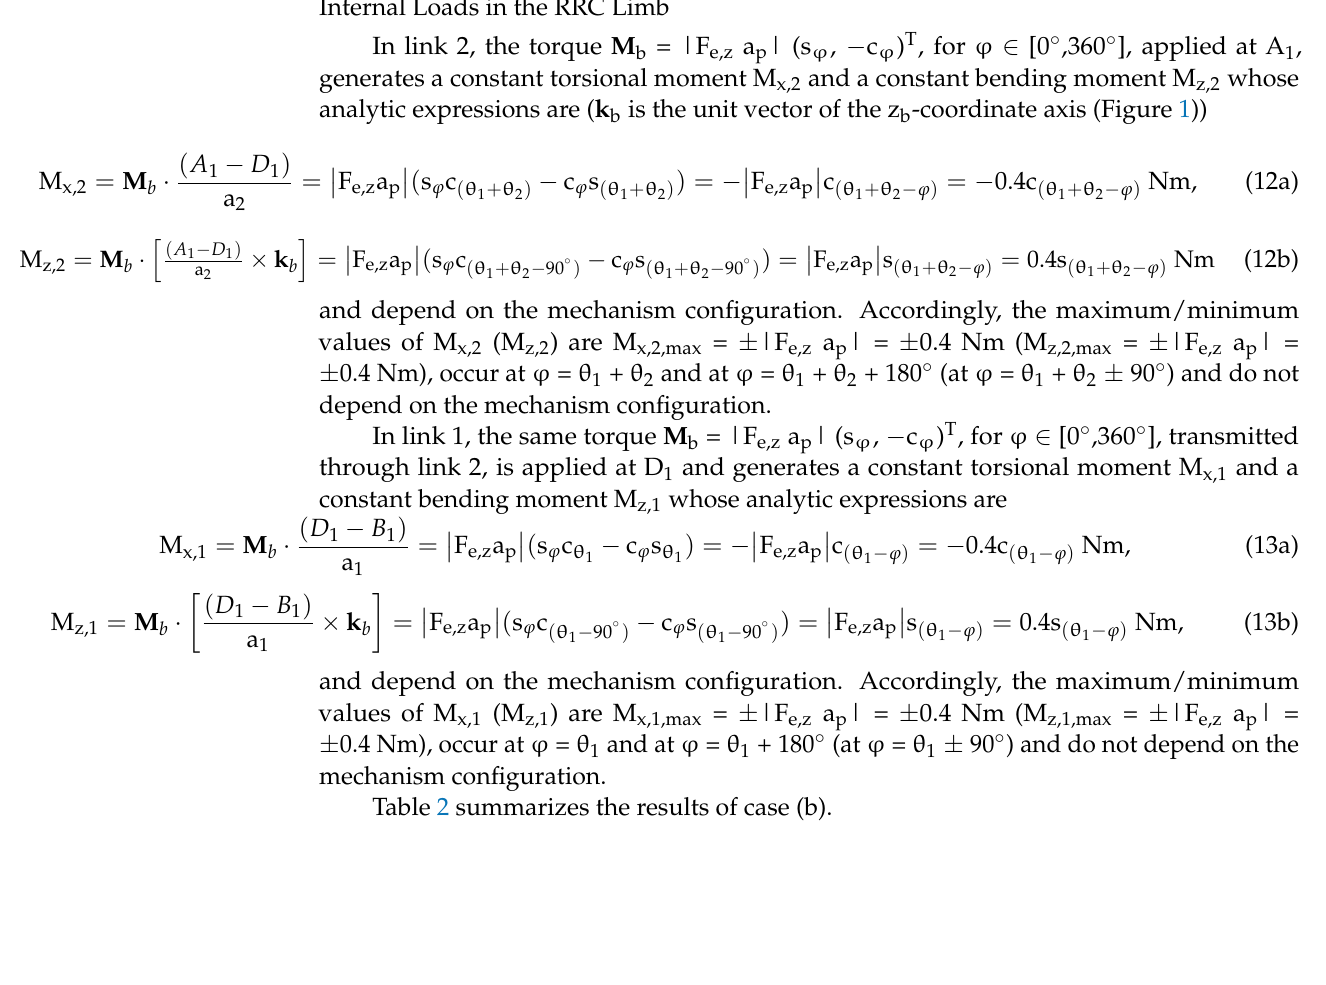
Figure 4. Scaled top view of a LaMaViP’s CRS-RRC, sized according to the results of the dimensional synthesis [19], at the configuration where θ 4 reaches its maximum value.